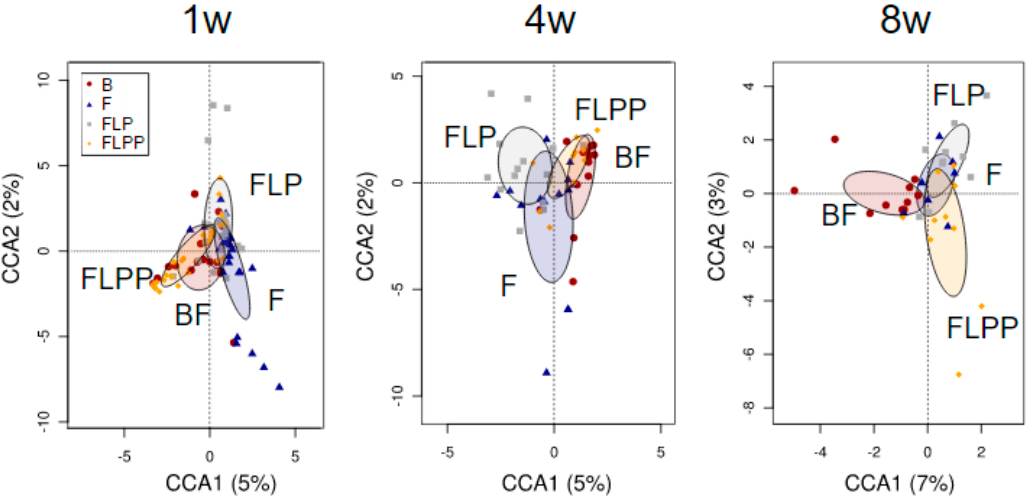
Figure 4. Canonical correspondence analysis at genus level for the nutritional intervention groups (PP data set). Ellipses indicates the 95% confidence intervals around the centroids. BF, breast fed; F, control formula; FLP, formula lactoferrin probiotic; FLPP, formula lactoferrin probiotic prebiotic.